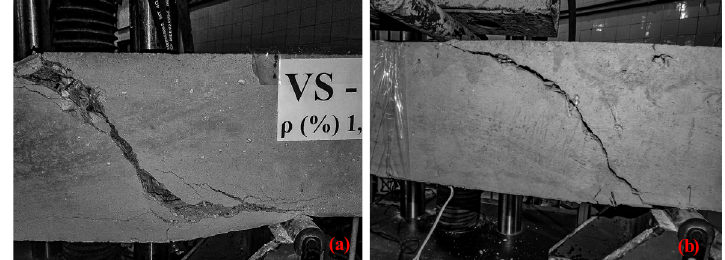
Figure 7. Failure pattern: (a) RC e (b) SFRC.